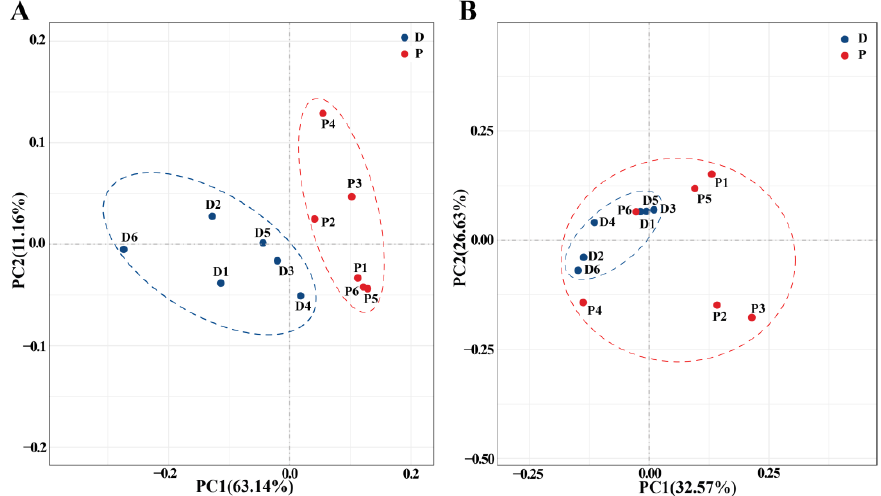
Figure 2. Effect of the fungicide prochloraz on soil microbial OTU abundance based on PCoA. ( A ) Bacteria; ( B ) Fungi. D and P represent decline-diseased trees alone or in combination with the fungicide prochloraz, respectively.